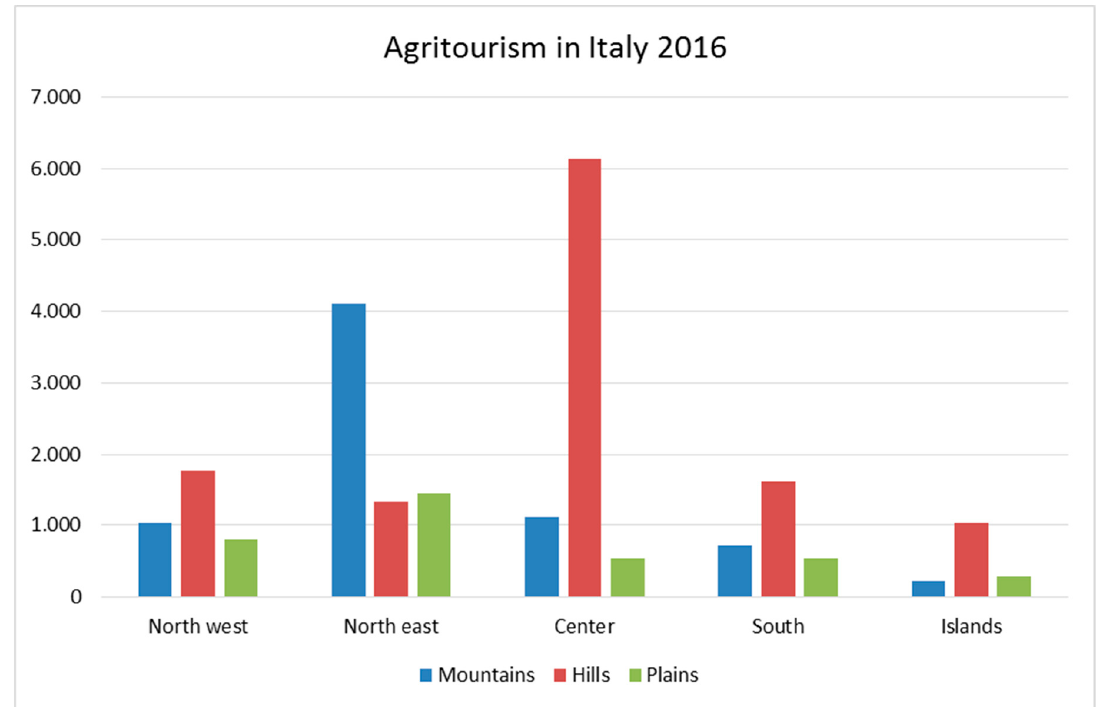
Figure 1. The distribution of agritourism in Italy shows a higher number in the central part of the country and on the mountains. These confirm that hilly areas and mountains, less developed than the plains but where we find most of the forests, have attractive landscapes. The small number of businesses in the south and the islands are mostly due to organizational problems of this sector, and these areas have usually a higher number of unique landscapes compared to the rest of the country.